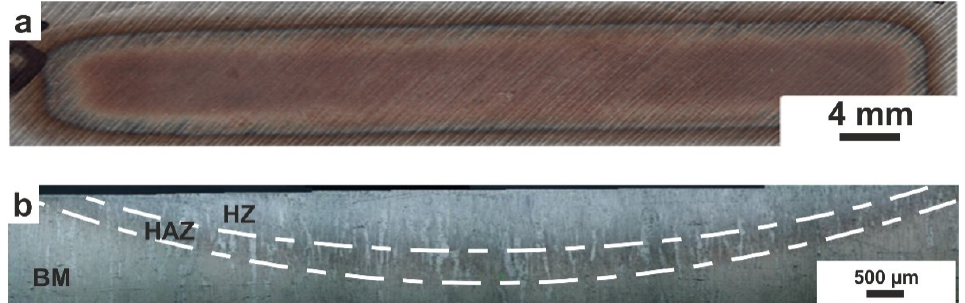
Figure 4. Microstructure of a hardened sample, mode No. 5: ( a ) image of a hardened track; ( b ) image of a microspecimen.